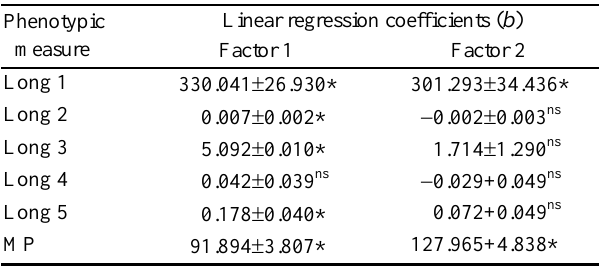
Table 6. Linear regression coefficients ( b ) of factors and their respective standard error on different longevity measures and first lactation milk